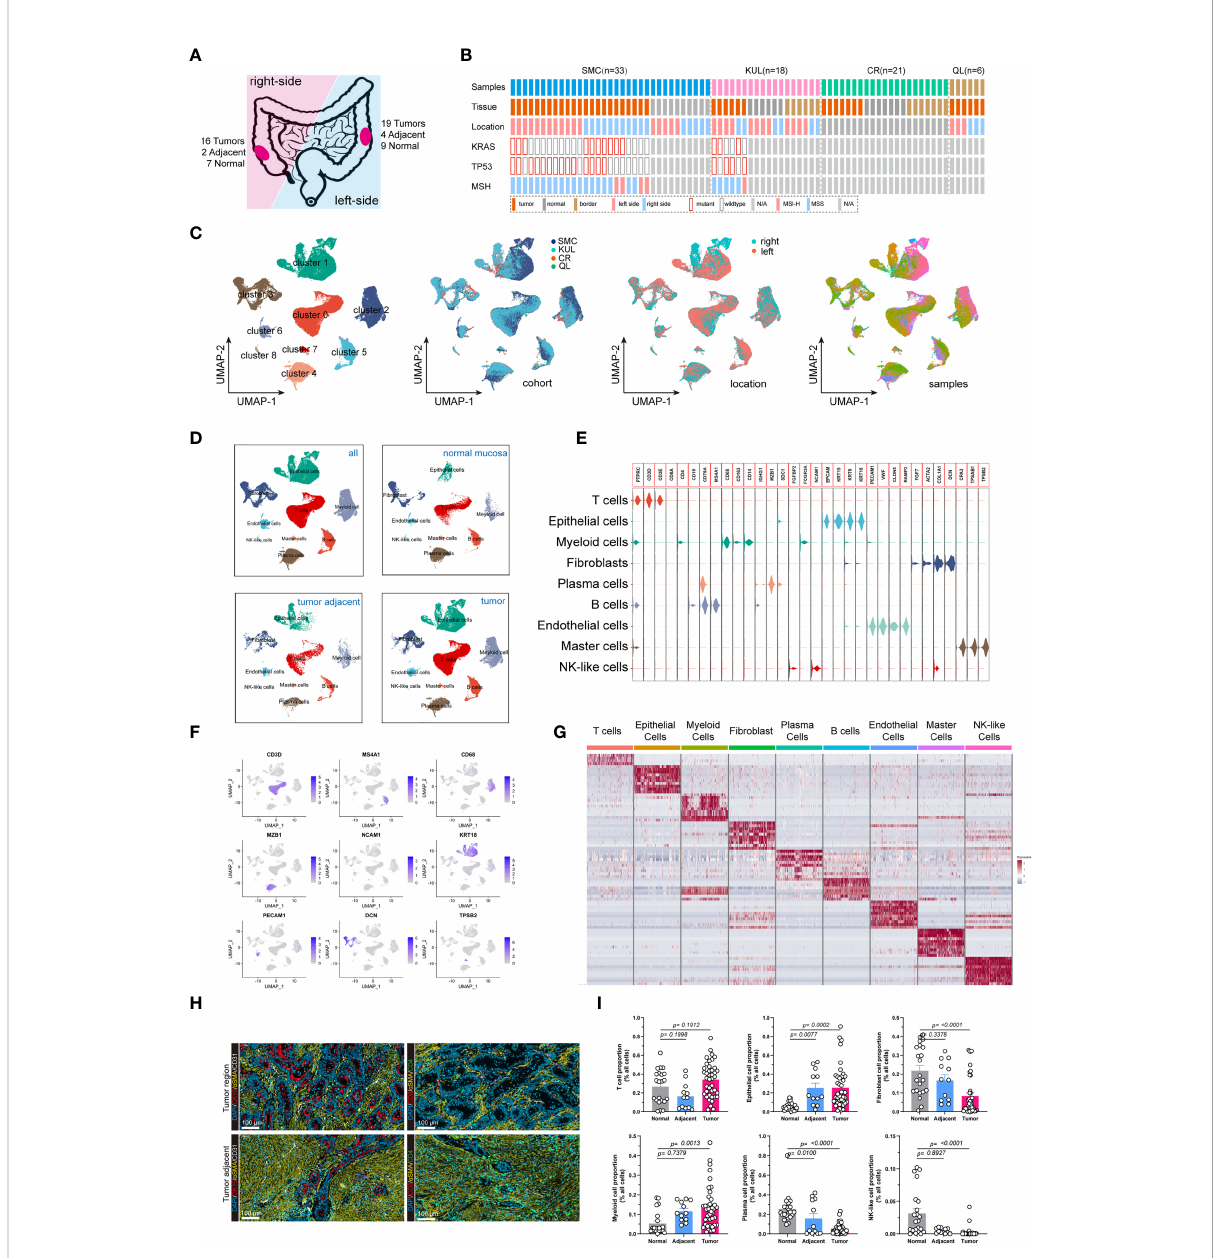
FIGURE 1 Integrated single-cell transcriptome atlas of colorectal cancer. (A, B) Schematic diagram depicted the (A) tumor sideness and (B) mutations status information. The tumor location indicated the sideness of the colorectal cancer (left-sided or right-sided). The KRAS gene primarily included RAS activating mutations such as KRAS G12D and KRAS G12C . Whereas the TP53 gene had more diverse mutations sites. The patient cohort information was provided to identify the origins of the patients. (C) UMAP dimension reduction of all 71,946 cells, and visualization of the characteristics according to UMAP clusters, cells origin cohorts, tumor location and sample identity. (D) UMAP plots displayed 9 major cell-types (epithelial cells, myeloid cells, B cells, T cells, plasma cells, master cells, NK-like cells, endothelial cells and fi broblasts) by tissue types. (E) Violin plots displayed the expression of marker genes across the 9 major cell types. (F) UMAP plots demonstrated the expression of key marker genes (CD3D, MS4A1, CD68, MZB1, NCAM1, KRT, PECAM1, DCN, TPSB2) across the 9 major cell types. (G) Heatmap depicted the top 10 differentially expressed marker genes across the 9 major cell types. For each group, 500 cells were randomly selected to draw the heatmap. (H) Representative images of immuno fl uorescent-stained cytokeratin, a -SMA, CD31, CD4 and CD8 in human colorectal cancer (upper panel) and tumor adjacent tissue (lower panel). (I) Bar plot demonstrated the proportion of T cells, Epithelial cells, Fibroblasts, Myeloid cells, Plasma cell, and NK-like cells across normal mucosa, tumor adjacent and colorectal tumor